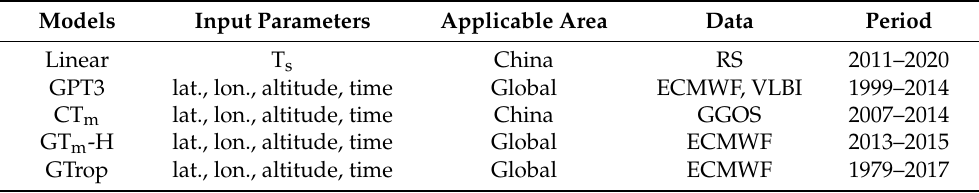
Table 1. Input parameters and application areas of the five selected T m